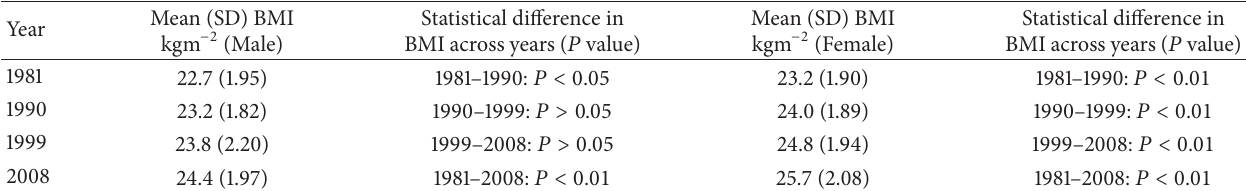
Table 1: Differences in mean BMI from 1981 to 2008 for both